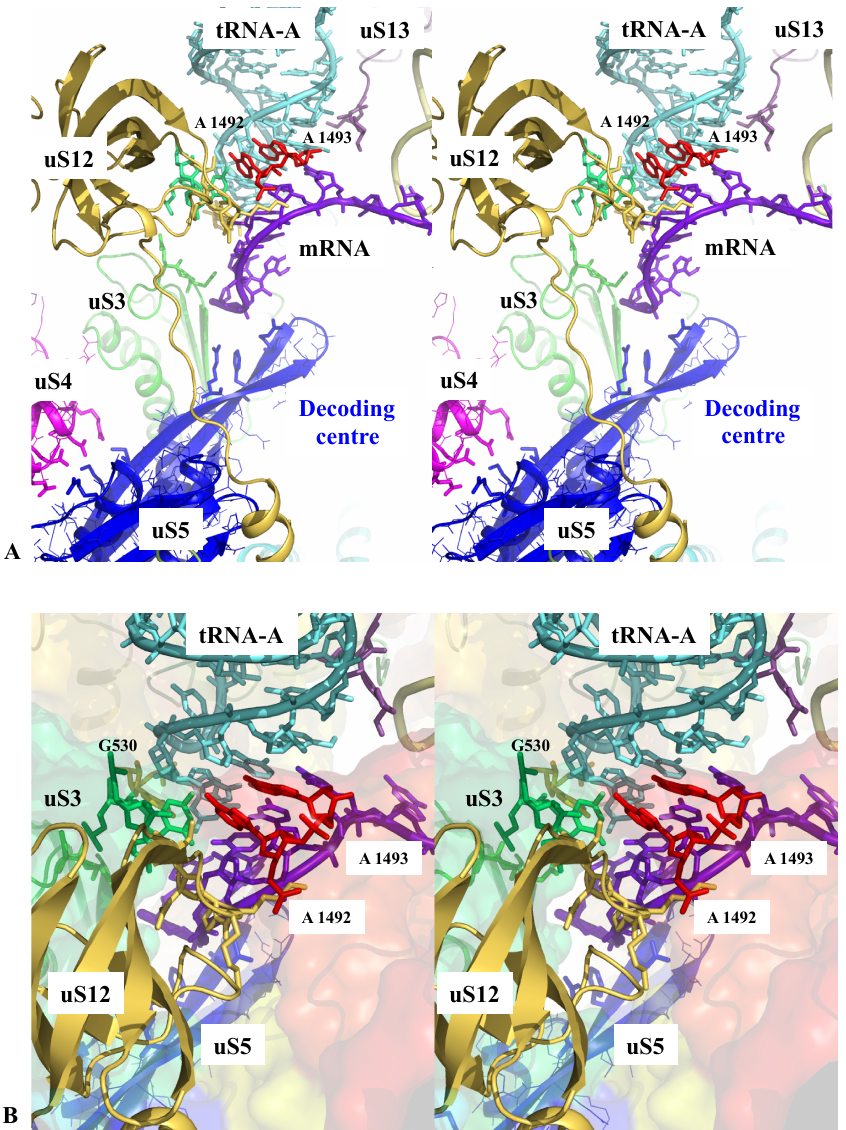
Figure 1. Sensing the decoding centre. Stereoviews of key r-protein and rRNA elements contacting the codon-anticodon interaction between the tRNA-A and the mRNA within the decoding centre. ( A ) overall view; ( B ) detail of the interactions; the rRNA is represented by a transparent surface coloured in the function of the RNA domains (from blue to red in the 5 ′ -3 ′ direction) (pdb_id: 4y4p).